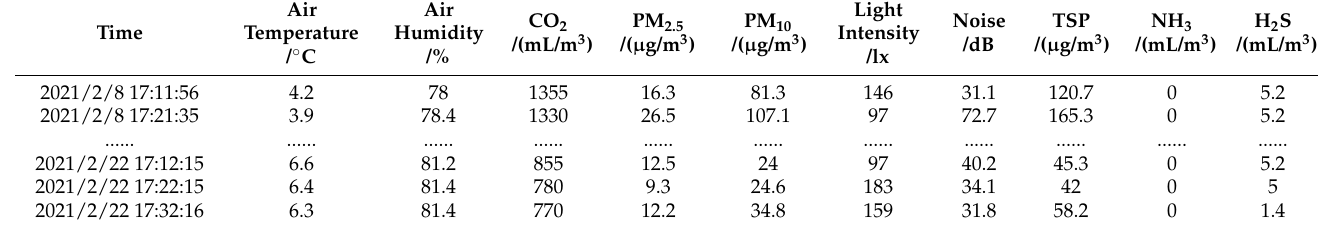
Table 1. Experimental original data collected from February 8 to 22, 2021.